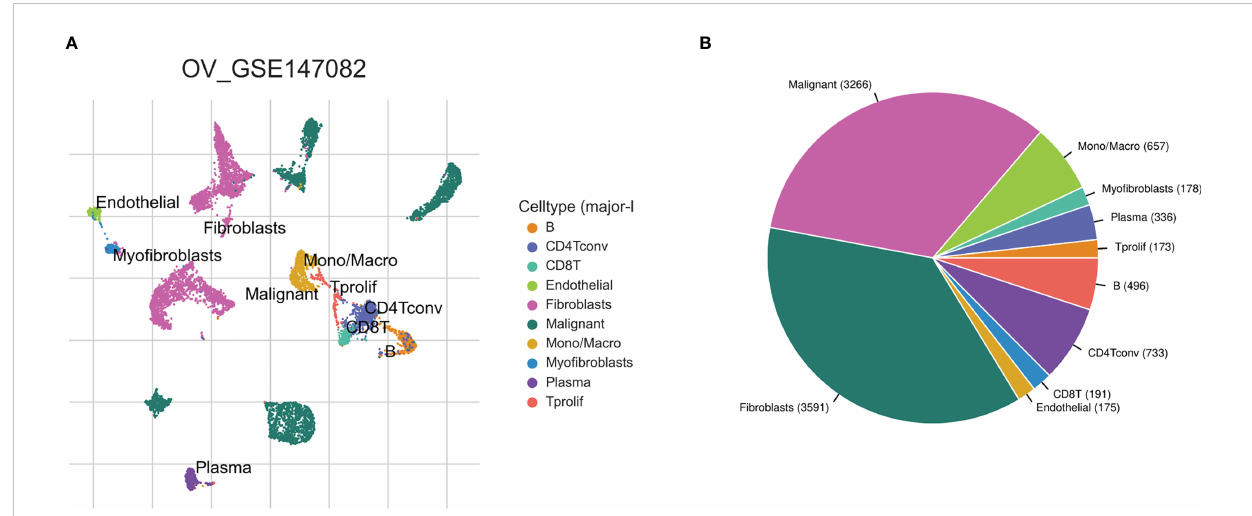
FIGURE 3 Ovary cancer single-cell data analysis based on the GSE147082 dataset. (A) The UMAP plots with cells coloured by cell type were displayed. (B) The pie plot showed the cell number distribution of each cell